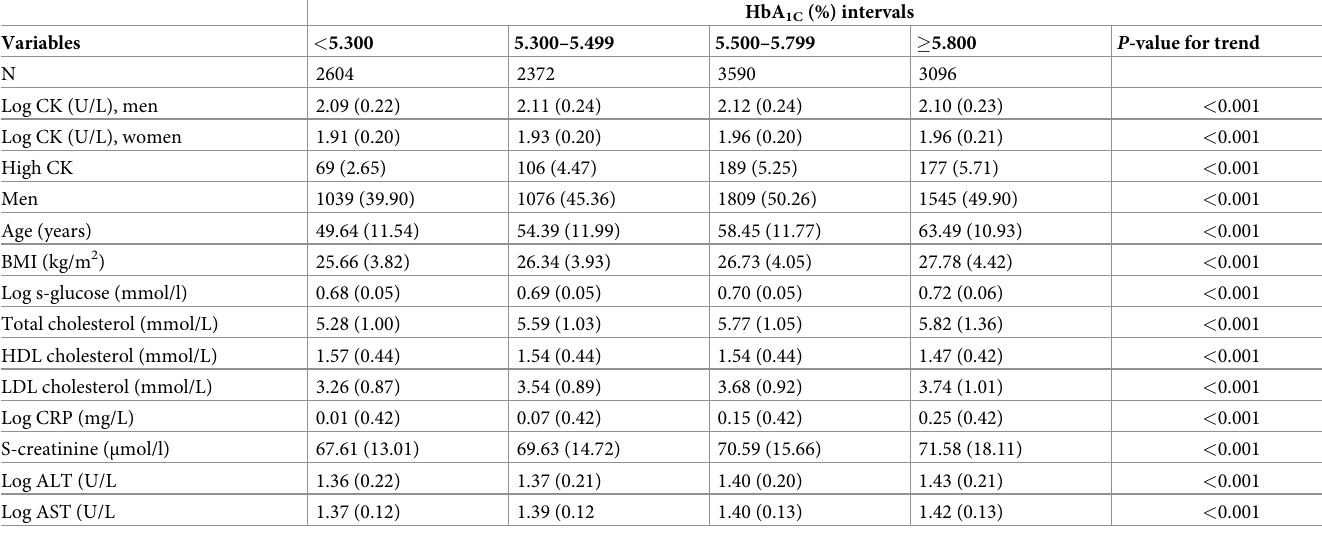
Table 2. Clinical characteristics and endpoint variables in 11662 participants by HbA 1C (%) quartiles. Data are presented as mean (SD) or numbers (%).